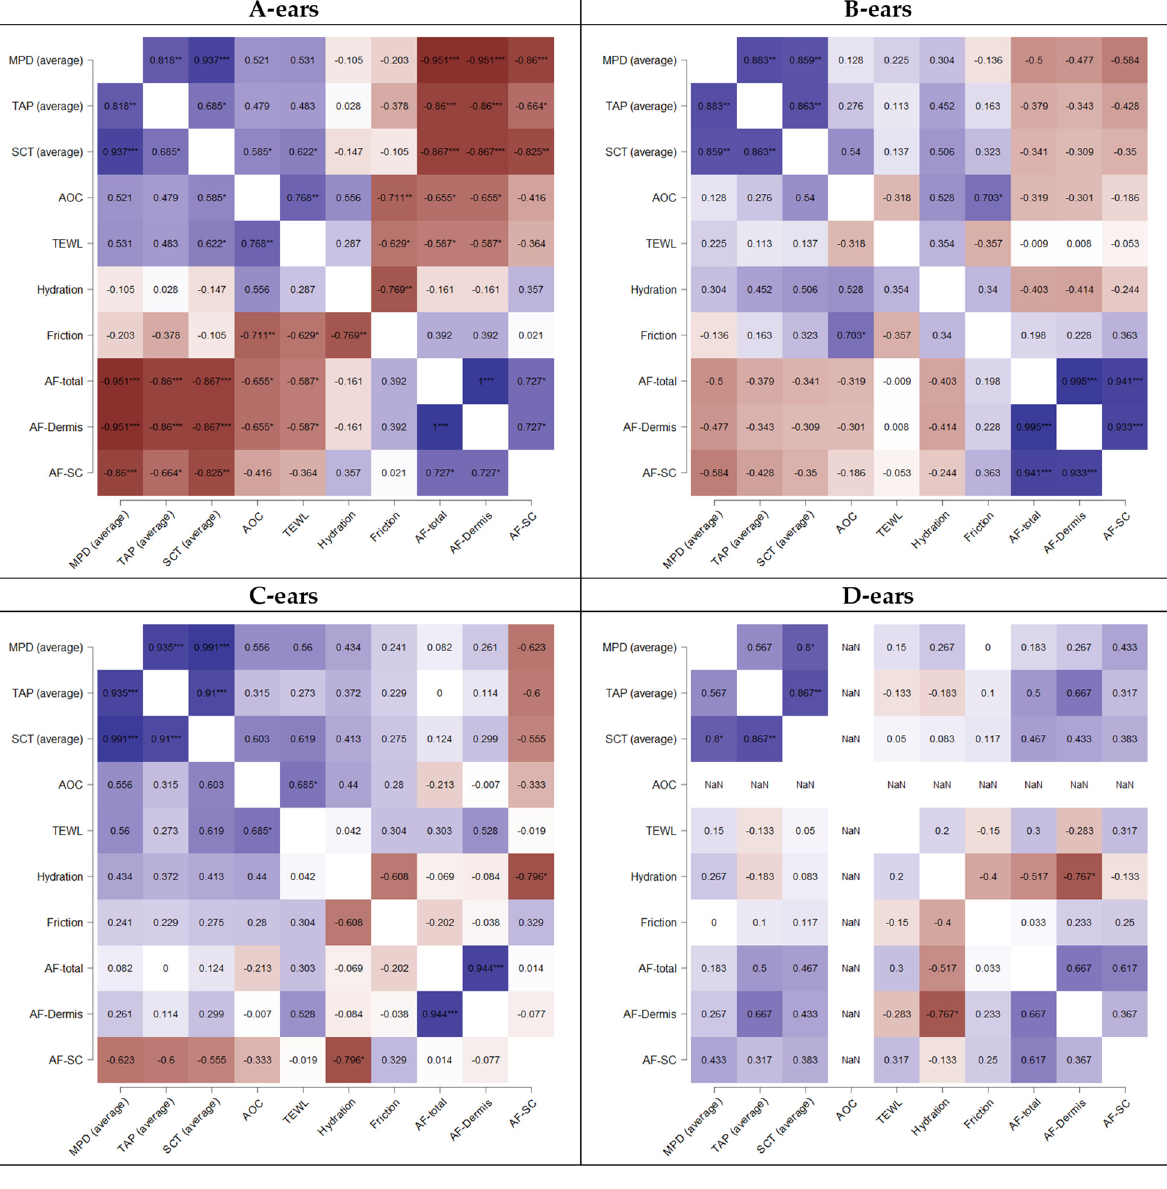
Figure 8. Correlation of penetration values and skin parameters (Spearman’s rho). Explanations cf.